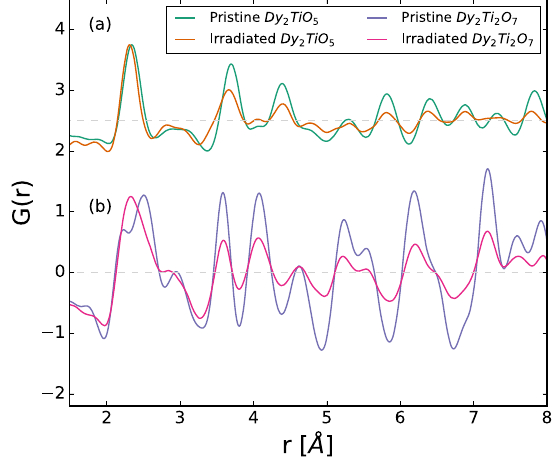
Fig. 4 Neutron pair distribution function (PDF) for pristine and irradiated Dy 2 TiO 5 . G ( r ) is proportional to the probability of speci fi c interatomic correlations at distance r . The dashed line indicates the maximum r -value for the coordination polyhedra region of the PDF. Loss of long-range structural coherency is evident at larger r -values by pronounced peak-intensity reduction with little changes to peak width.